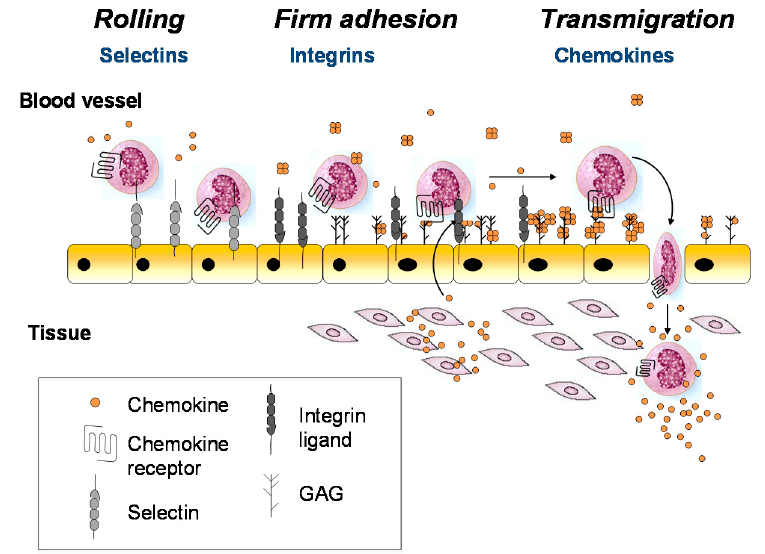
Figure 1. The role of GAGs in cell recruitment. Chemokines (yellow circles) produced by the underlying tissue are immobilized on cell surface GAGs. Circulating leukocytes first roll upon interaction with selectins (pale gray symbols), followed by firm adhesion to integrin ligands (dark gray symbols) following integrin activation on the leukocytes after which they transmigrate into the tissue. Although chemokines are depicted as a single species, many different chemokines may be involved.